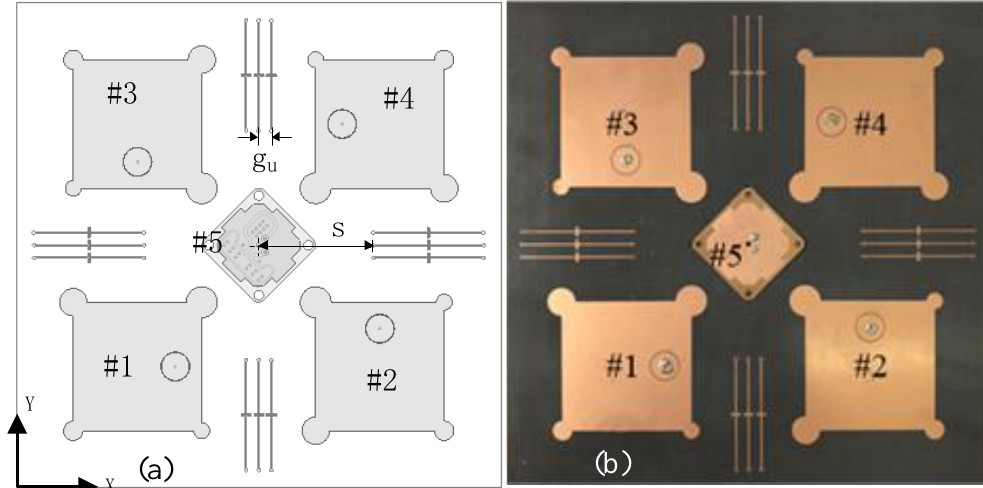
Figure 5. The array with the isolation structures ( a ) simulation model and ( b ) fabricated array.